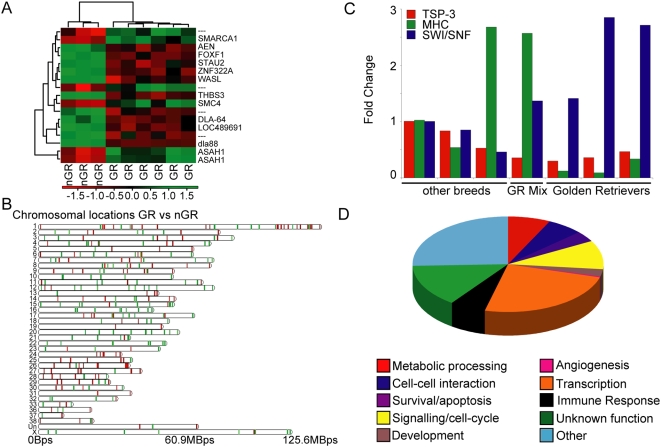
Golden Retriever Hemangiosarcoma Cells Segregate from Non-Golden Retriever Hemangiosarcoma Cells via Their Expression Profile.A. Hierarchical clustering of 6 Golden Retriever (GR) hemangiosarcoma samples versus 3 non-Golden Retriever (nGR) hemangiosarcoma samples (GEO series record GSE15086). Increasing green intensity indicates increased gene expression, increasing red intensity indicates decreased gene expression, and black indicates no change. Bars represent groups that cluster together. B. Gene differences between Golden Retrievers (GR) and non-Golden Retrievers (nGR) were plotted according to their cytogenetic location along the 38 autosomes and the X chromosome. Tick marks represent individual genes that show differential regulation, with the color intensity (green to black to red) representing expression changes as described in part A. Genes plotted received a p-value<0.05 and were derived from ANOVA analysis of the global list of filtered genes. C. Quantitative expression analysis of 3 genes found in panel A, TSP-3, DLA88 (MHC), and SMARCA1 (SWI/SNF) that were differentially expressed between Golden Retrievers with hemangiosarcoma and other breeds with hemangiosarcoma. Samples were evaluated for gene expression changes by RT-PCR followed by qPCR. One sample originating from a non Golden Retriever dog (Dal-4) was normalized to 1.0 and used as a reference; gene expression is presented as fold change compared to the reference sample. The samples used for real time PCR analysis (in the order presented) include CHAD P9, Dal-4, Joey, DD1, CHAD G6, CHAD G4, and Frog. D. Schematic representation of gene expression changes between Golden Retrievers and non Golden Retrievers with hemangiosarcoma grouped by biological function using ONTO/express gene ontology program (vortex.cs.wayne.edu/Projects.html).